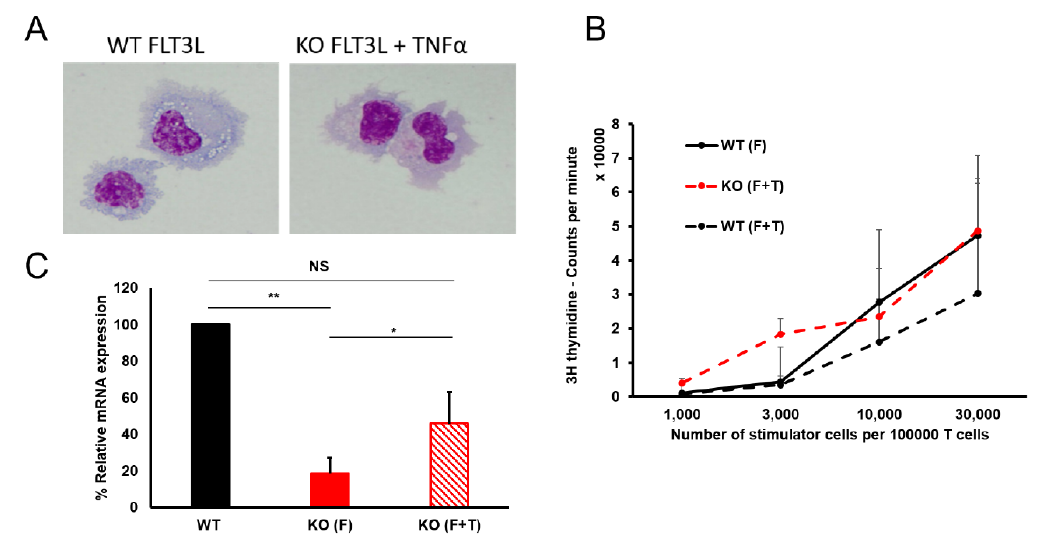
Figure 6. DCs formed from KO HSPCs by TNF α and FLT3L are functionally active. ( A ) Morphological comparison of DCs from WT HSPCs treated with FLT3L and DCs of KO HSPCs treated with TNF α and FLT3L for 8 days. ( B ) Allogenic MLR after 5 days of stimulation shows comparable T-cell activation potential of DCs from WT HSPCs treated with FLT3L and DCs of KO HSPCs treated with TNF α and FLT3L. Data represent mean + SD ( n = 4–6 mice). ( C ) RT qPCR analysis shows an increase in expression of Cx3cr1 in KO HSPCs treated for 4 h with TNF α and FLT3L, as compared to FLT3L only. Data represent fold change relative to WT normalized with two endogenous housekeeping genes ( n = 3 mice, * p < 0.05, ** p < 0.01; NS denotes nonsignificant).